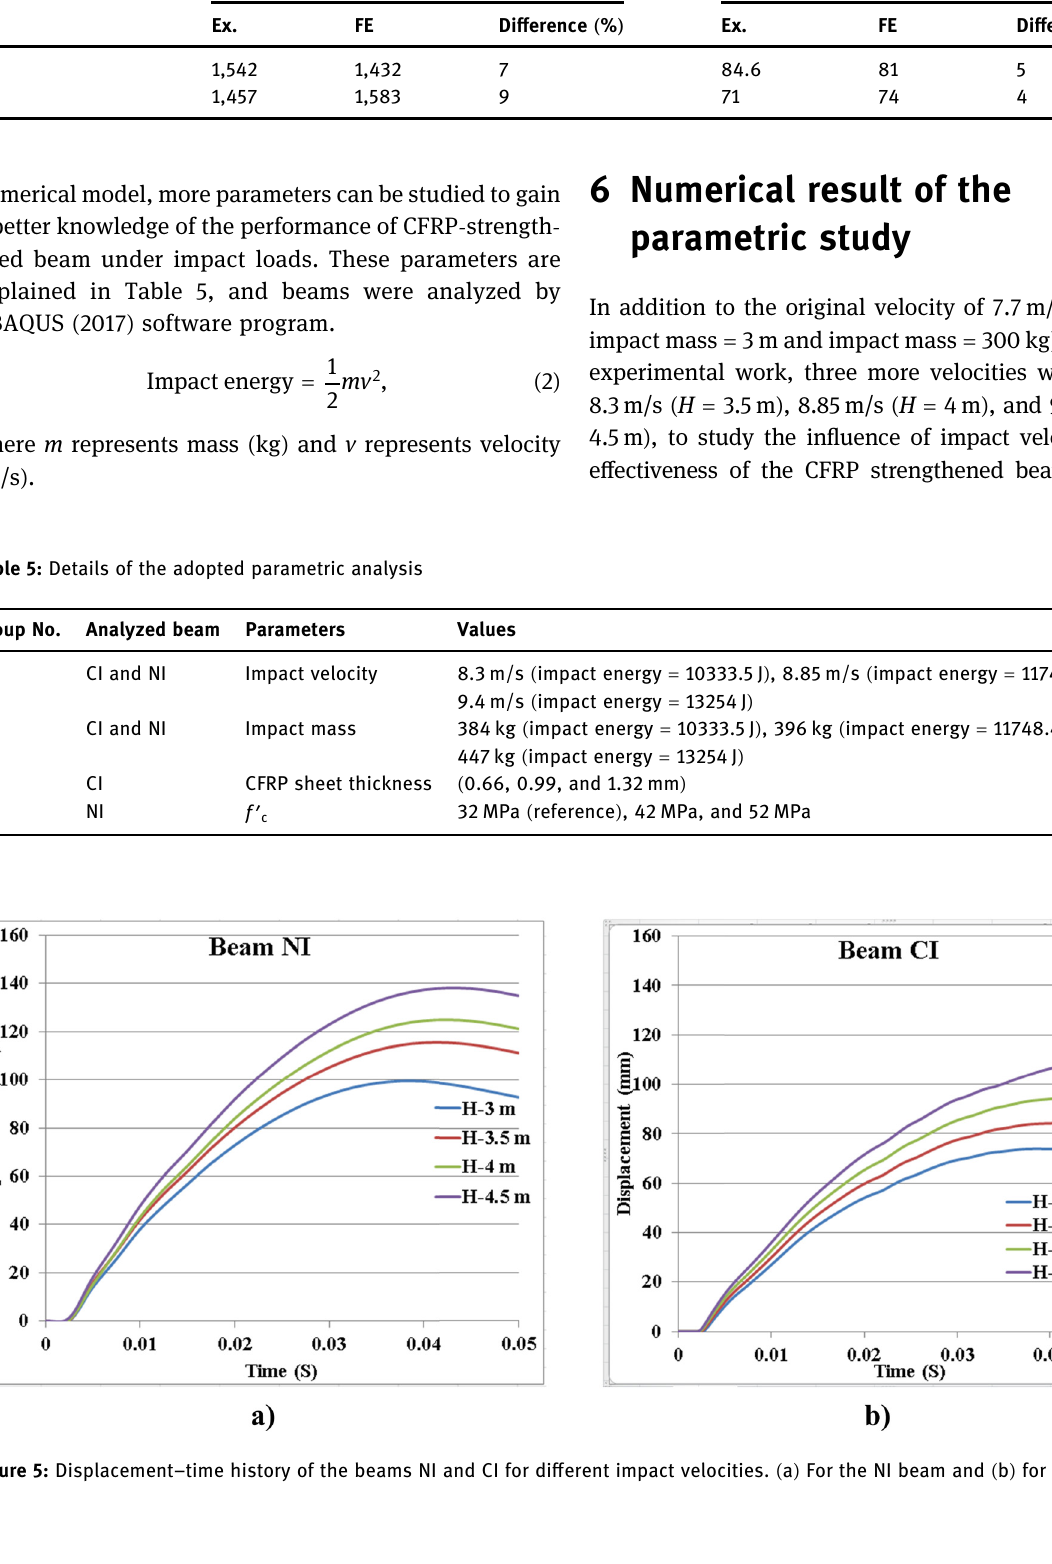
Table 4: Summary of the simulation result Beam designate